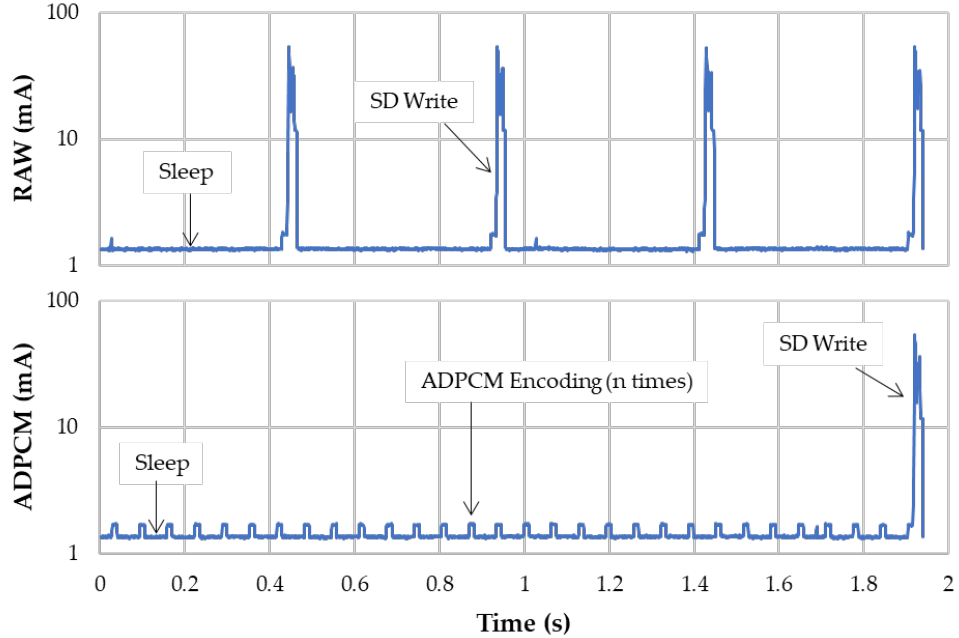
Figure 4. Comparison of transient currents during audio recording without ( top ) and with ( bottom ) embedded ADPCM compression. Table 2. Energy required for a 2 s recording without and with embedded ADPCM compression.